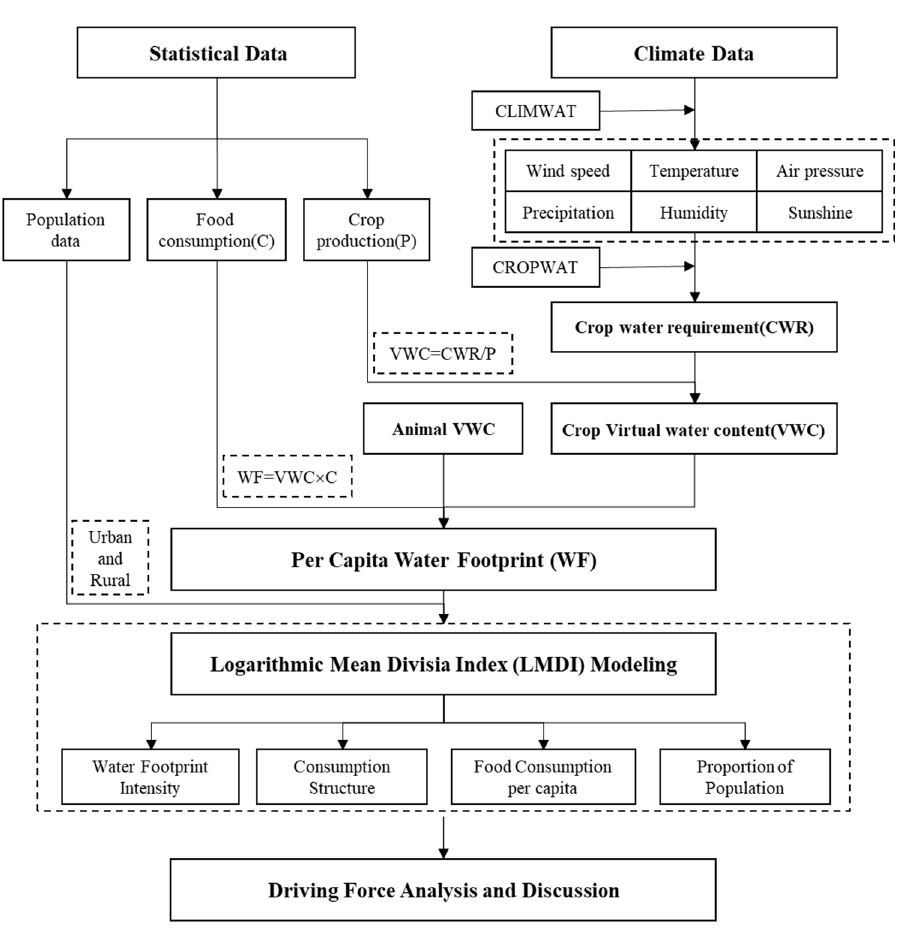
Figure 2. Major data sources and conceptual framework.